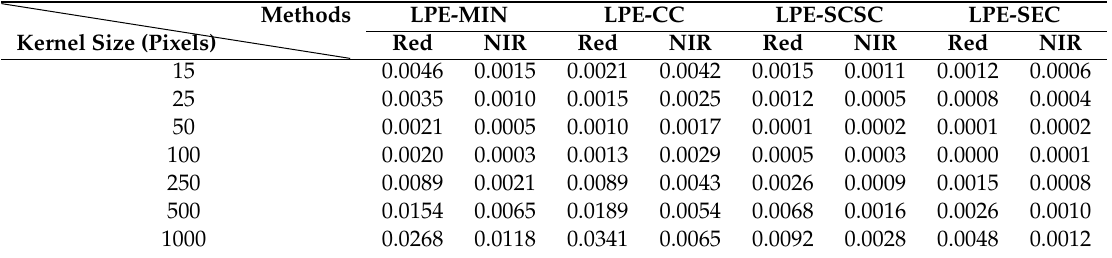
Table 1. The determination coe ffi cients values (R 2 ) of the linear relationship between IC and the reflectance for the local parameter estimation-topographic correction (LPE-TC) methods with the kernel sizes ranging from 15 pixels to 1000 pixels.